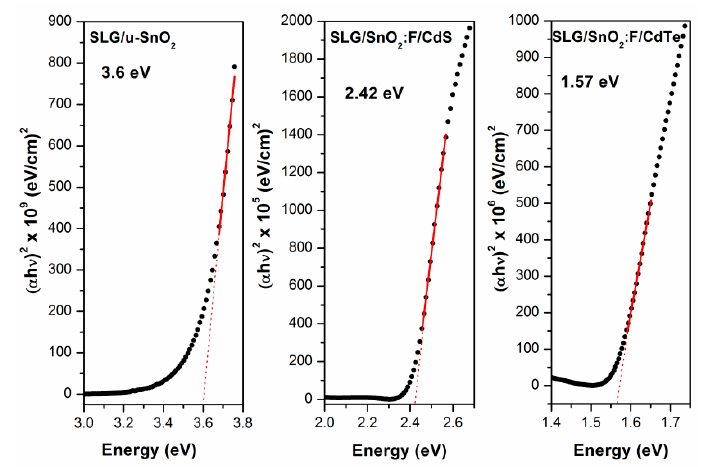
Figure 2. Tauc plots used for band gap calculation of the different materials forming the heterostructure. The extrapolation of the ( α h υ ) 2 vs. E linear region fitting is also shown. Diffractograms for the different samples are shown in Figure 3. For SnO 2 , only peaks